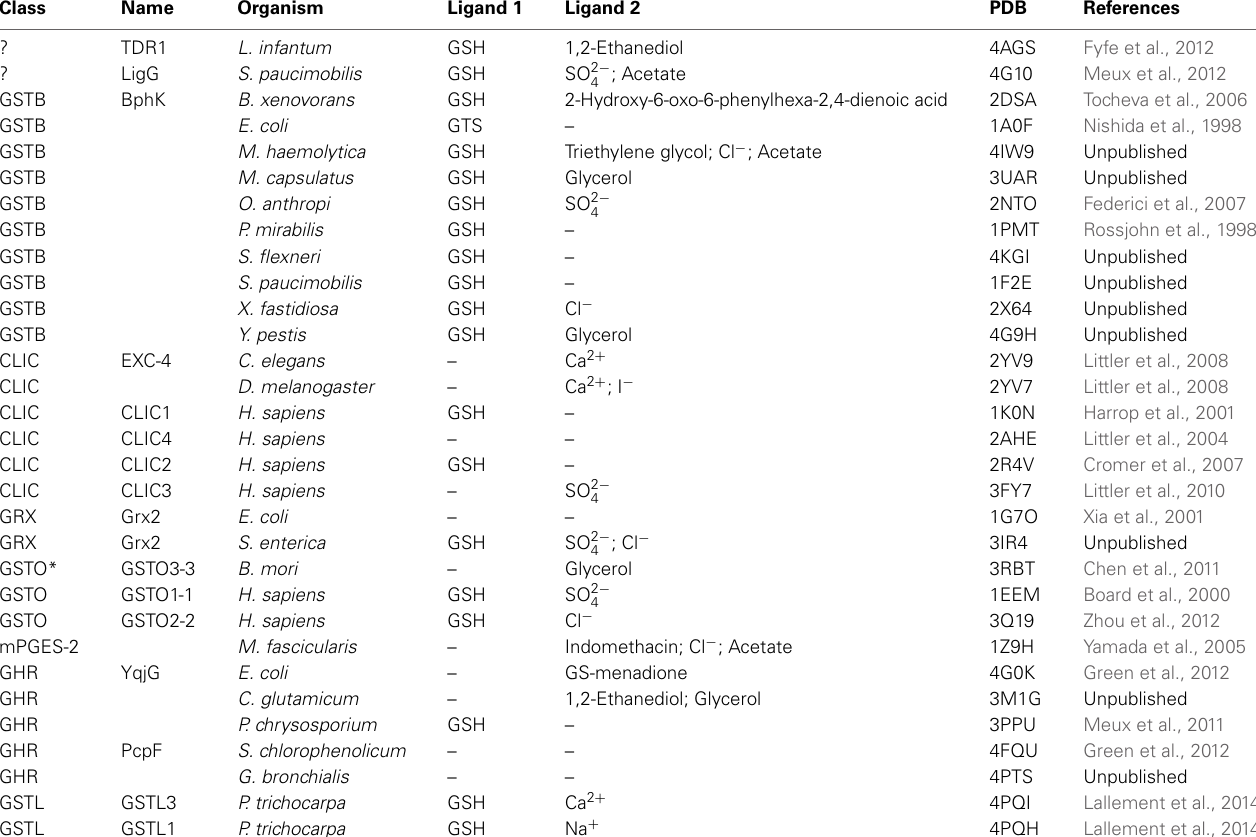
Table 4 | Tridimensional structures of Cys-GSTs from all kingdoms.